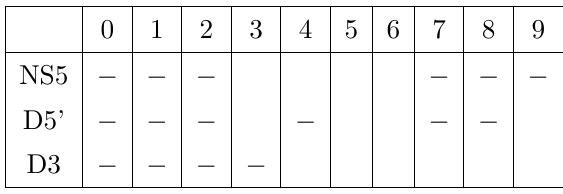
Table 2 . The brane setup giving rise to the 3 d FT [SU( N + 1)] gauge theory.